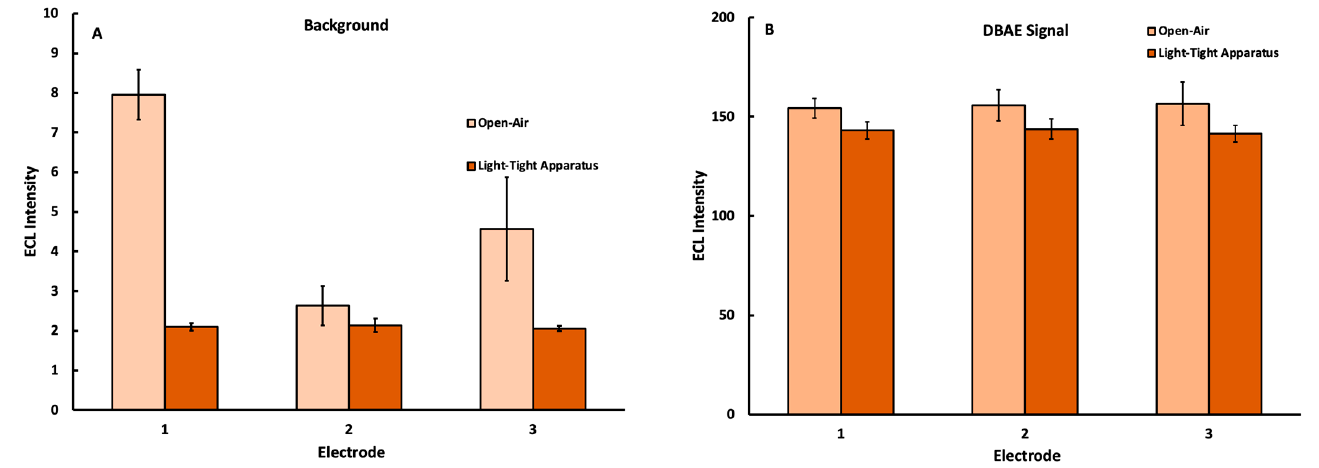
Figure 4. ECL signal collected with a mobile phone detector under an applied potential of 1.1 V for three different electrodes using solutions containing 5.0 mM Ru(bpy) 32+ plus ( A ) 0.00 mM and ( B ) 0.45 mM DBAE with trials captured either in open air or using the light-tight housing in Figure 1 (n = 10 at each electrode).